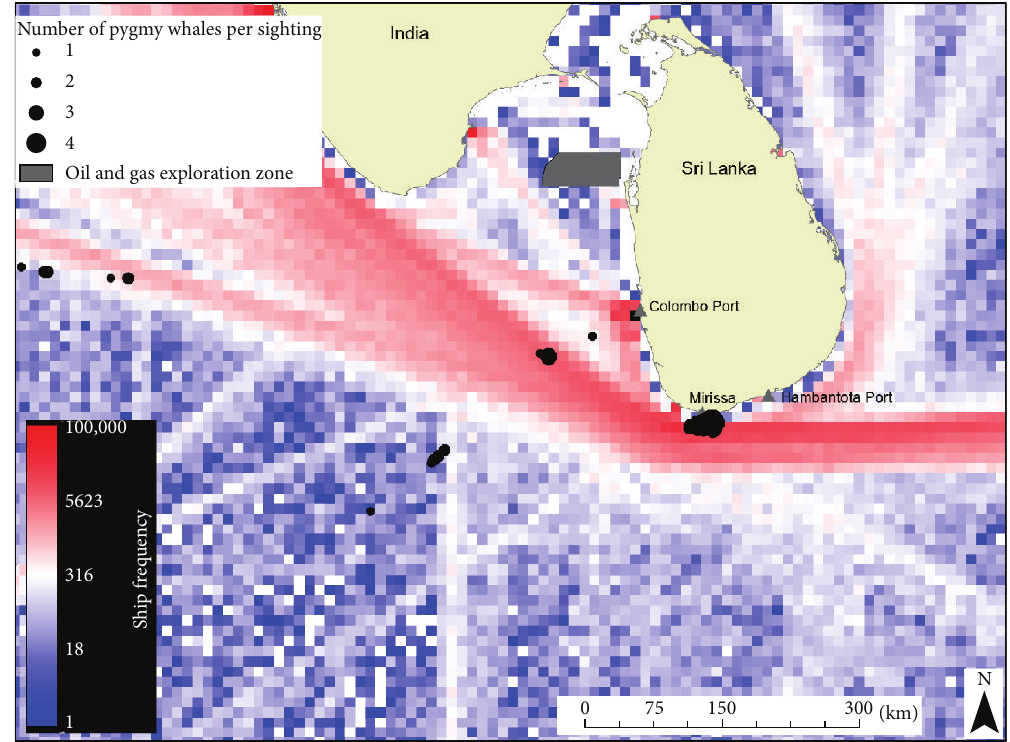
Figure 3: Map showing ship traffic frequency (red-blue), oil and gas exploration zone SL2007-01-01 which was the first to be explored in Sri Lankan waters in 2011 (gray box), pygmy blue whale sightings (black dots), and areas of relevance around Sri Lanka. Data sources include Potemra [59], National Aquatic Resources Research and Development Agency [60], Ballance and Pitman [61], de Vos et al. [19], and de Vos, unpublished